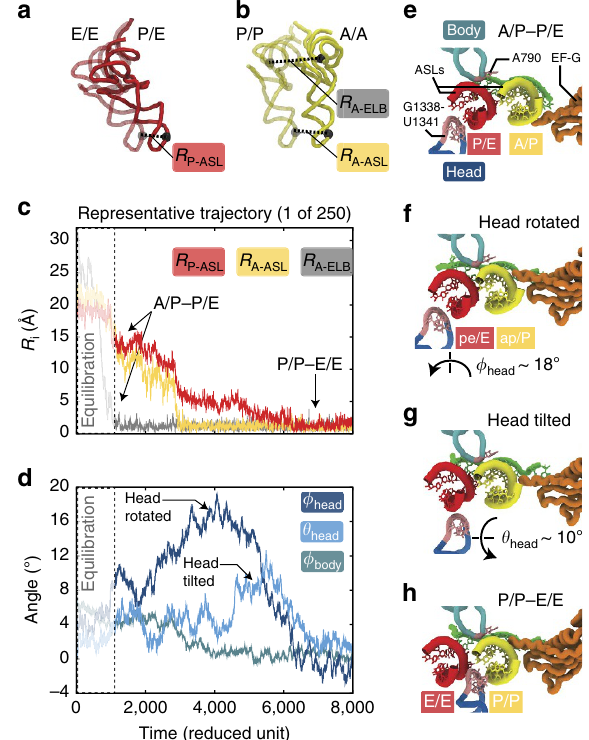
Figure 2 | Complex 30S translocation dynamics emerge from a simple energetic model. ( a , b ) Multiple coordinates are used to describe tRNA movement. R P (cid:2) ASL and R A (cid:2) ASL are distances of the anticodon stem-loops (ASLs) of the P and A site tRNAs (red and yellow) to their E/E and P/P positions. These ASL distances were calculated after 30S body alignment of the simulated trajectory to the POST conformation (see Supplementary Information for details). R A (cid:2) ELB is the distance of the A-tRNA elbow to its location when in the P/P conformation. Elbow distance is determined after 23S alignment of the trajectory to the POST conformation. In a and b , the P/E and A/A tRNA conformations (initial configuration in the simulation) are shown as opaque. The endpoint E/E and P/P conformations are in ghost representation. ( c , d ) Representative time traces for a single simulated event (1 of 250) shows large-scale movements of the tRNAs (20–30Å, c ) and transient subunit rotations in the ribosome ( d ). In all 250 simulations, formation of the A/P–P/E conformation, where R A (cid:2) ELB (grey line) decreases from B 30 to B 0Å, precedes displacement of the ASLs (red and yellow lines). In c and d , the dashed white-faded boxes outline the initial equilibration period, where the A-site tRNA elbow relaxes to the 50SP site and adopts an A/P conformation. ( e – h ) Structural snapshots of the mRNA binding track (from the perspective of the 50S subunit) during translocation illustrate the tRNA ASL positions, relative to the 30S body and head. During the initial equilibration period, the system adopts an A/P–P/E conformation ( e ). During translocation, the 30S head rotates ( f ), which is followed by back rotation and tilting of the head ( g ). Translocation is completed when the classical P/P–E/E conformation ( h ) is